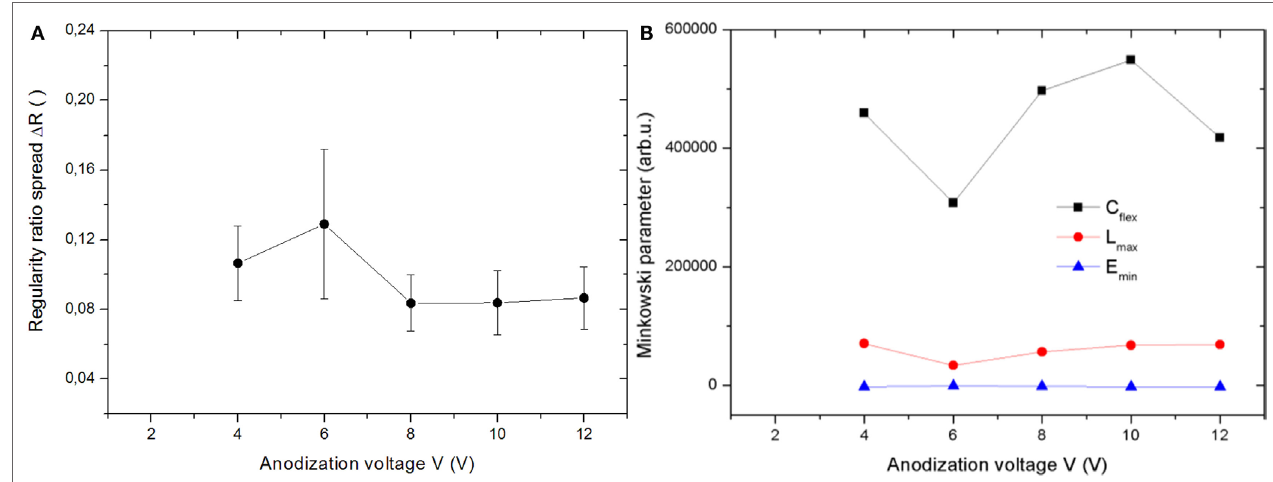
FigUre 3 | set of anodizations carried out at 30°c: (a) regularity ratio spread and (B) Minkowski parameters plotted versus the anodization voltage